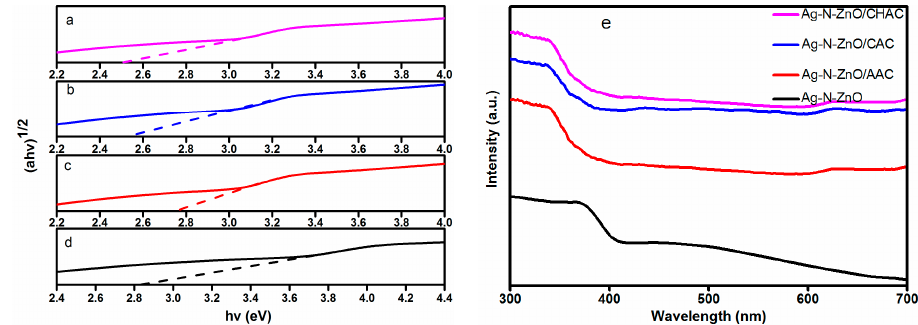
Figure 3. Direct band gap of ( a ) Ag-N-ZnO/CHAC, ( b ) Ag-N-ZnO/CAC, ( c ) Ag-N-ZnO/AAC ( d ) Ag-N-ZnO and ( e ) UV-vis diffuse absorption spectra of all